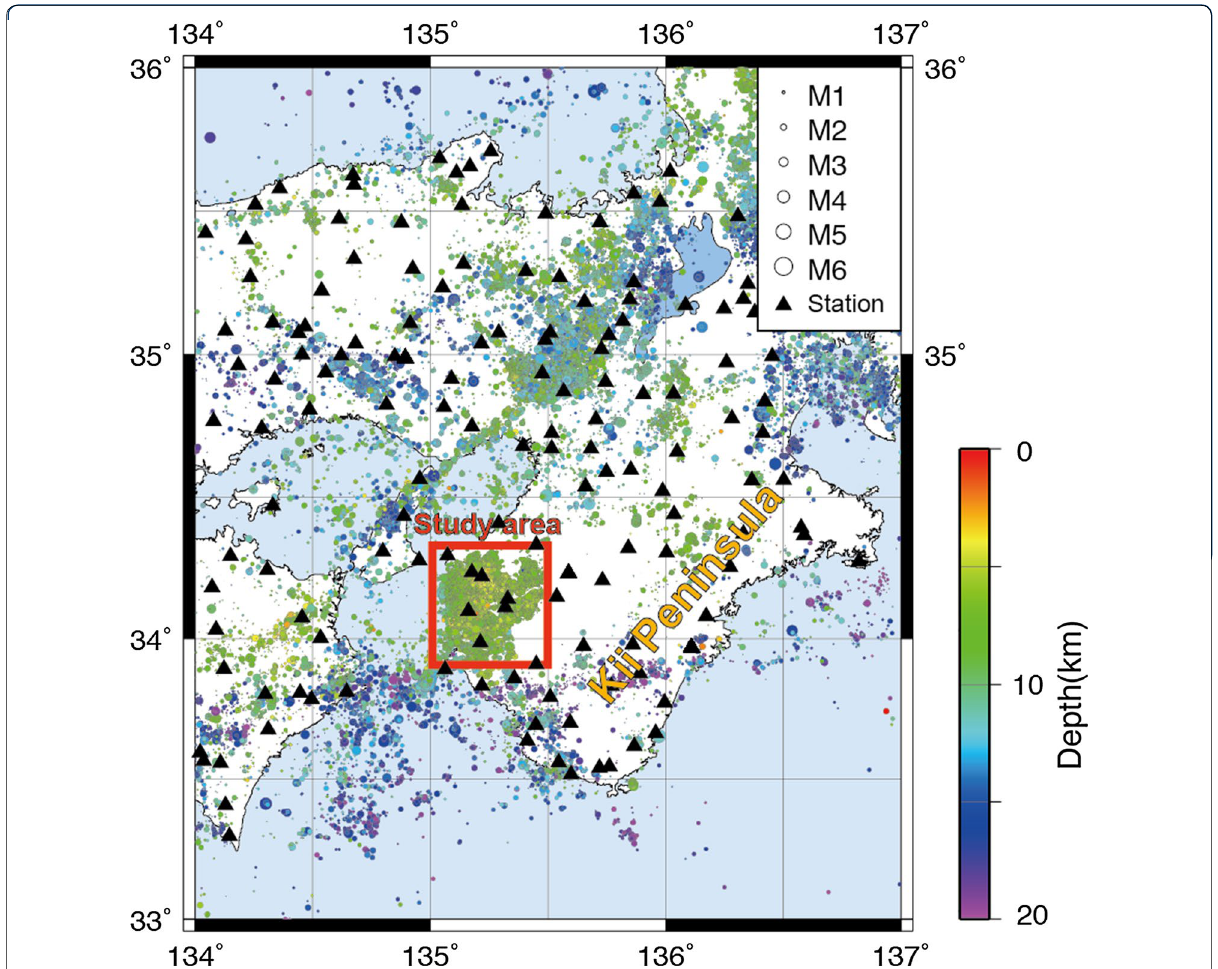
Fig. 1 Hypocenter distribution in around the Kii Peninsula, Japan. Dots represent hypocenters from the Japan Meteorological Agency (JMA) catalog shallower than or equal to 20 km for the period from 2005 to 2013. The color of each dot represents the depth to the event. Red rectangle represents the study area. Triangles indicate the seismograph stations belonging to JMA, NIED and Kyoto University used to determine the focal mechanisms in this study. Averaged distance between two adjacent stations is about 10 km, and hypocenters and focal mechanisms are deter- mined using stations including a station with epicentral distance of less than 5 km in most